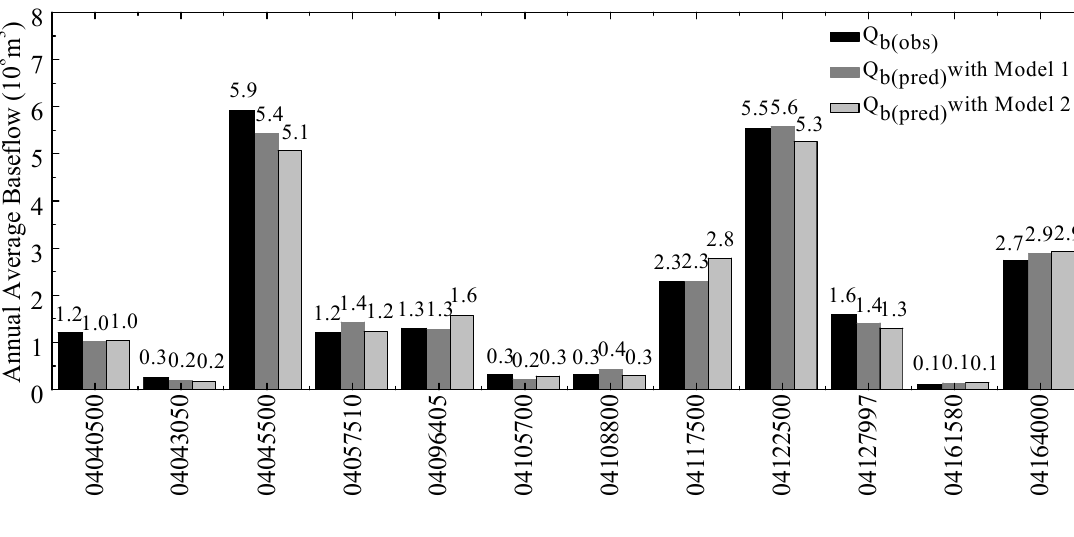
Figure 3. Predicted and observed BFI in watersheds used for model